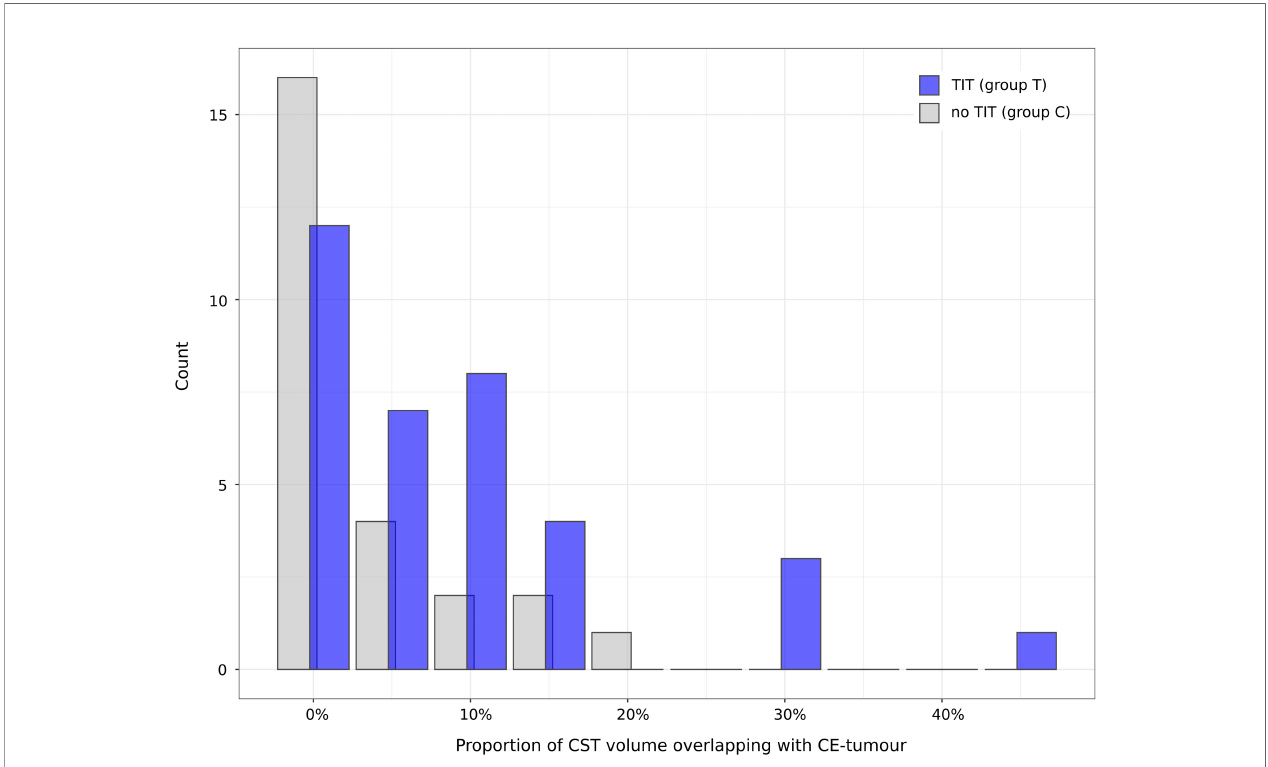
FIGURE 3 | Groupwise distribution of CST-overlap. The histogram displays the distribution of the proportional CST volume overlapping with CE-tumour (CST- overlap), grouped by TIT. The Wilcoxon test revealed a higher mean CST-overlap in group T compared to group C (8.7% ± 10.7% vs. 3.8% ± 5.7%; p = 0.022). X- axis: percentage of CST-overlap. Y-axis: count. Blue: group T (TIT; n = 35). Grey: group C (control, no TIT; n =